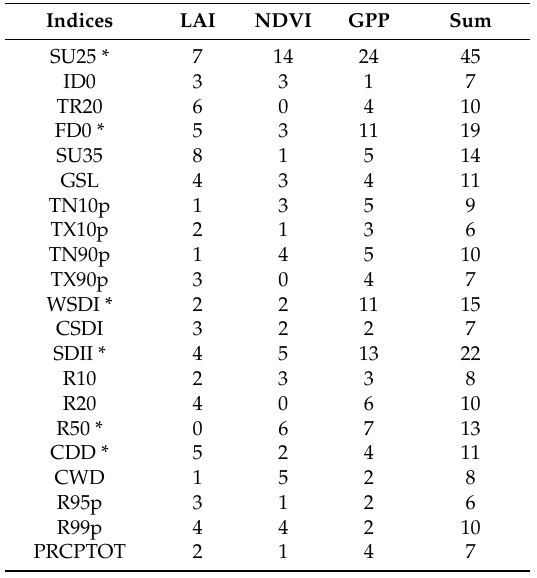
Table 3. The number of times that the corresponding climate index was chosen as the candidate variable when the stepwise linear regression was performed between the corresponding ecosystem variables and the 21 climate indices at 30 meteorological stations within the study